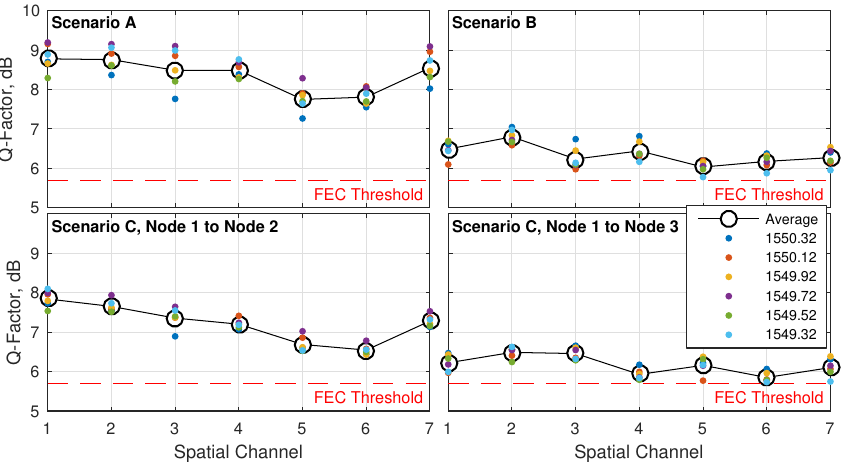
Figure 6. Q-factor estimates for each of the spatial channels comprising the cSSC when implementing scenarios A to